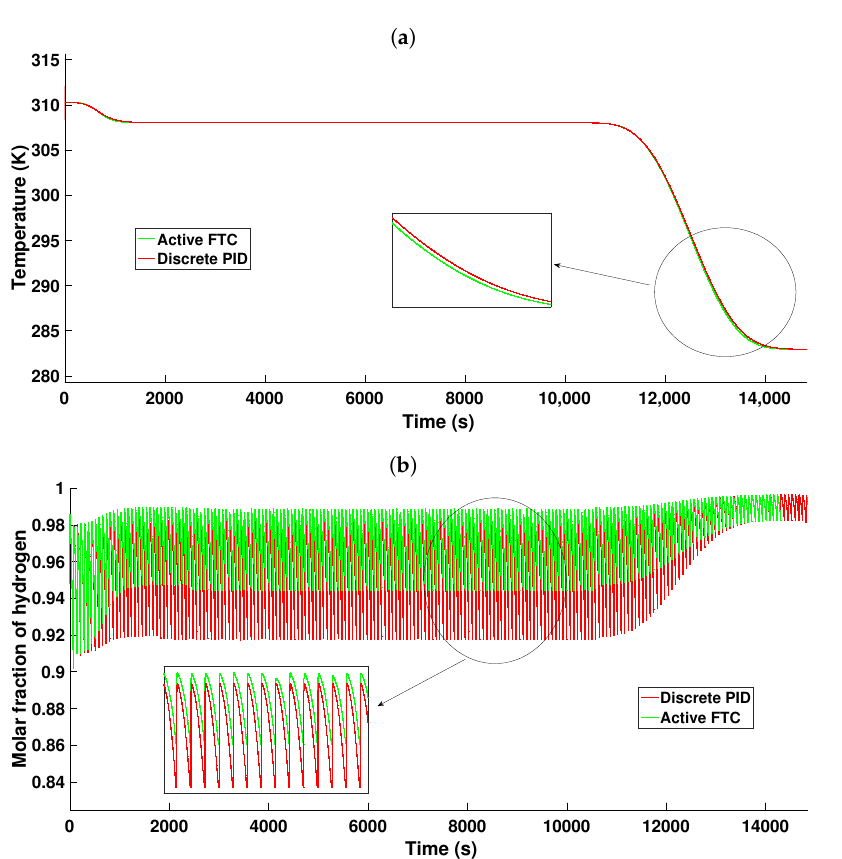
Figure 22. Scenario 2—Nominal controllers for following trajectory: ( a ) control signal generated by the active FTC and discrete PID controller, and ( b ) hydrogen purity with two trajectory changes on the PSA virtual plant.